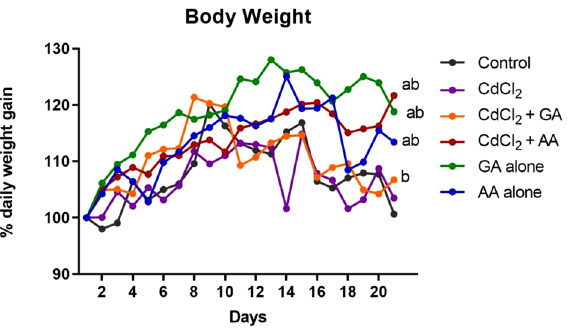
Figure 2. The body weight gain of rats expressed as percent of initial body weight exposed to Cadmium (CdCl 2 ) only, CdCl 2 and gallic acid (GA), CdCl 2 and ascorbic acid (AA), GA alone and AA alone compared with the control ( n =